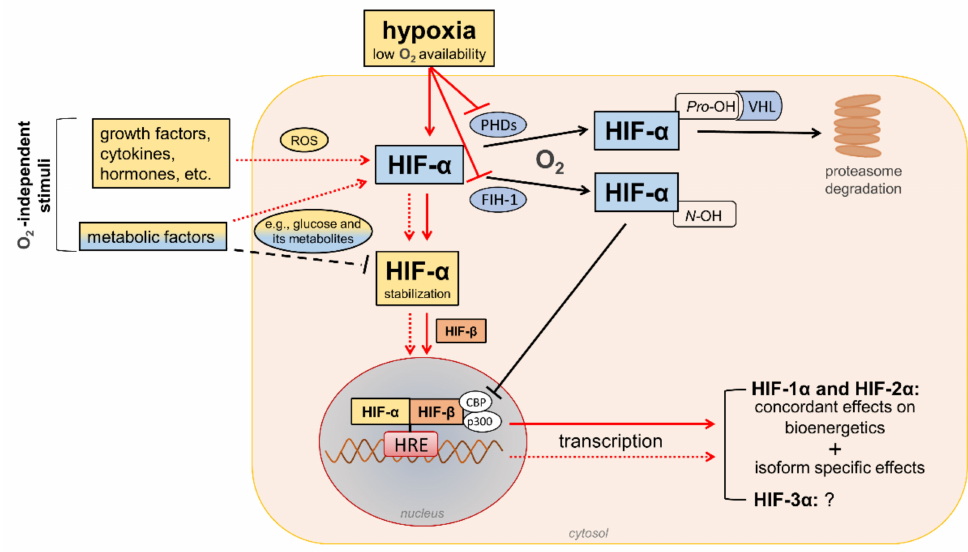
Figure 2. Regulation of hypoxia-inducible factor (HIF) signaling by oxygen (O 2 )-dependent and O 2 -independent mechanisms. There are conflicting opinions on the effects of metabolic factors, particularly hyperglycemia, on the stability of HIF- α proteins (mainly HIF-1 α ). Refer to the main text for detailed description. Black arrows/lines and light blue boxes/ovals indicate components and processes of the HIF- α degradation pathway in oxygenated cells (black solid arrows/lines) or metabolic factors that may impair HIF- α stabilization in hypoxic conditions (black dashed line). Red arrows/lines and yellow boxes indicate oxygen-dependent (red solid arrows/lines) and oxygen- independent stimuli (red dotted lines) promoting the stabilization and transcriptional activity of HIF- α proteins. ROS = reactive oxygen species; PHDs = prolyl hydroxylase domain proteins; FIH-1 = factor-inhibiting HIF-1; Pro-OH = proline hydroxylation; N-OH = asparagine hydroxylation; VHL = von Hippel–Lindau; CBP = cAMP response element-binding protein; p300 = E1A binding protein p300; HRE = hypoxia-response